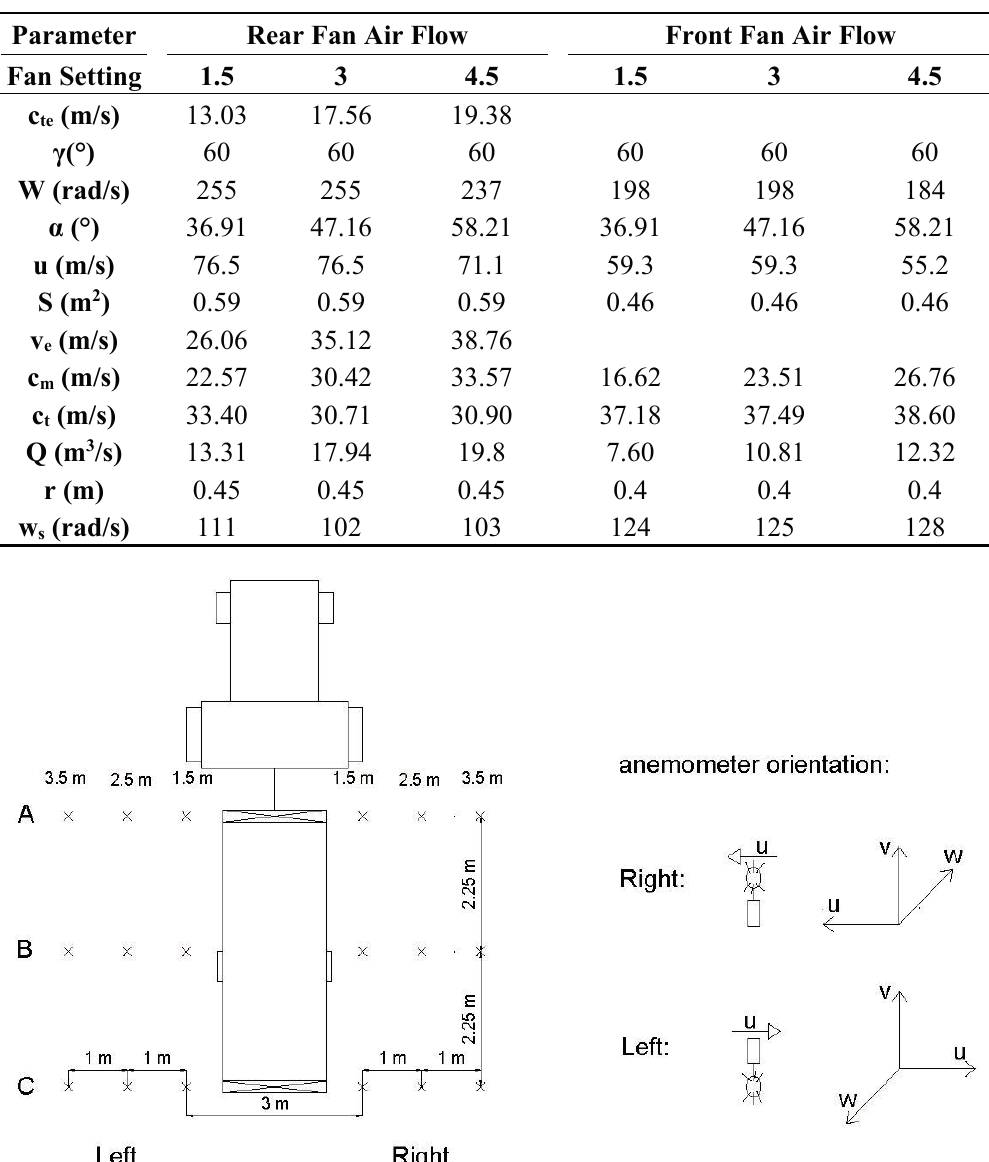
Table 1. Input data for CFD analysis.